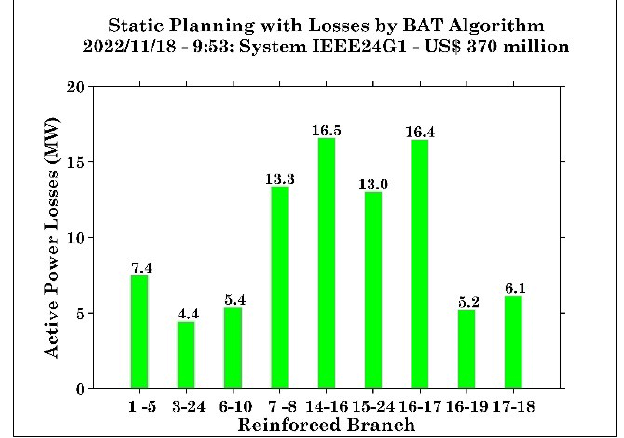
Figure 12: Case WOR - IEEE-24/41 test system.